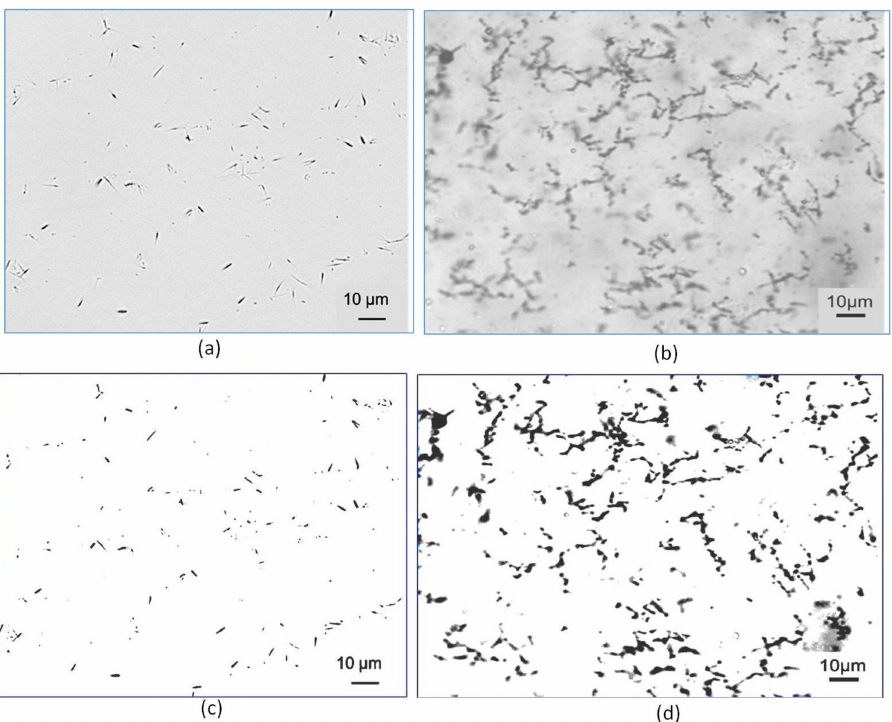
Figure 7. Optical Micrographs of the aqueous suspensions of ( a ) 0.2% MWCNT% with 5 wt.% Pluronic F-127, ( b ) 0.2% CNF with 5 wt.% Pluronic F-127, ( c , d ) are the high contrast micrographs of ( a , b ), respectively, showing the conductive networks formed by CNFs and MWCNTs.